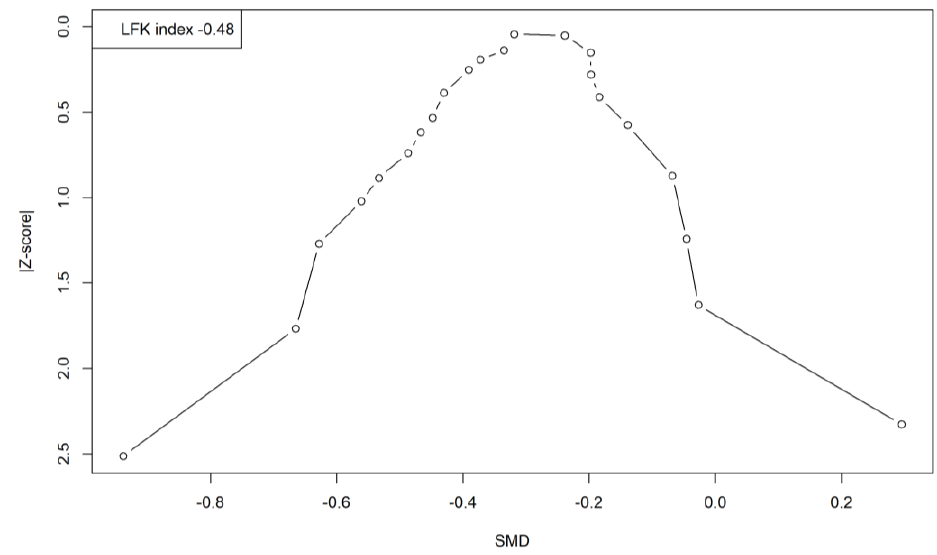
Figure A15. Doi plot and LFK index of the studies included in the sensitivity analysis.